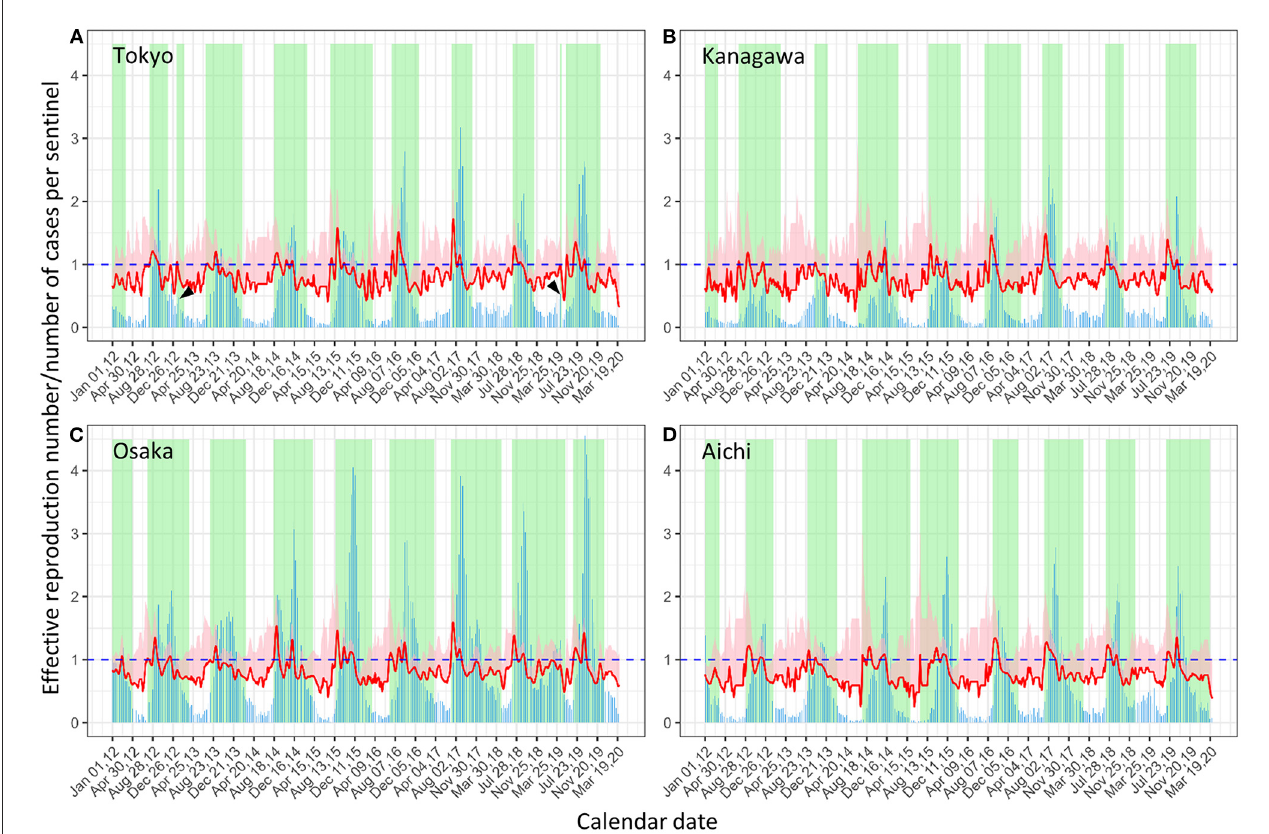
FIGURE2 Number of cases per sentinel (CPS) of respiratory syncytial virus infection from 2012 to 2019 with the effective reproduction number. (A–D) Tokyo (A) , Kanagawa (B) , Osaka (C) , and Aichi (D) Prefectures. The bar graph (blue) shows weekly CPS. The effective reproduction number is shown with 95% CI band (pink shade) and its lower bound (red line). The green rectangle shade shows the epidemic period (please refer to the main text and Figure 1 for the definition of the epidemic period). By this definition, small surges may be included (arrow heads).